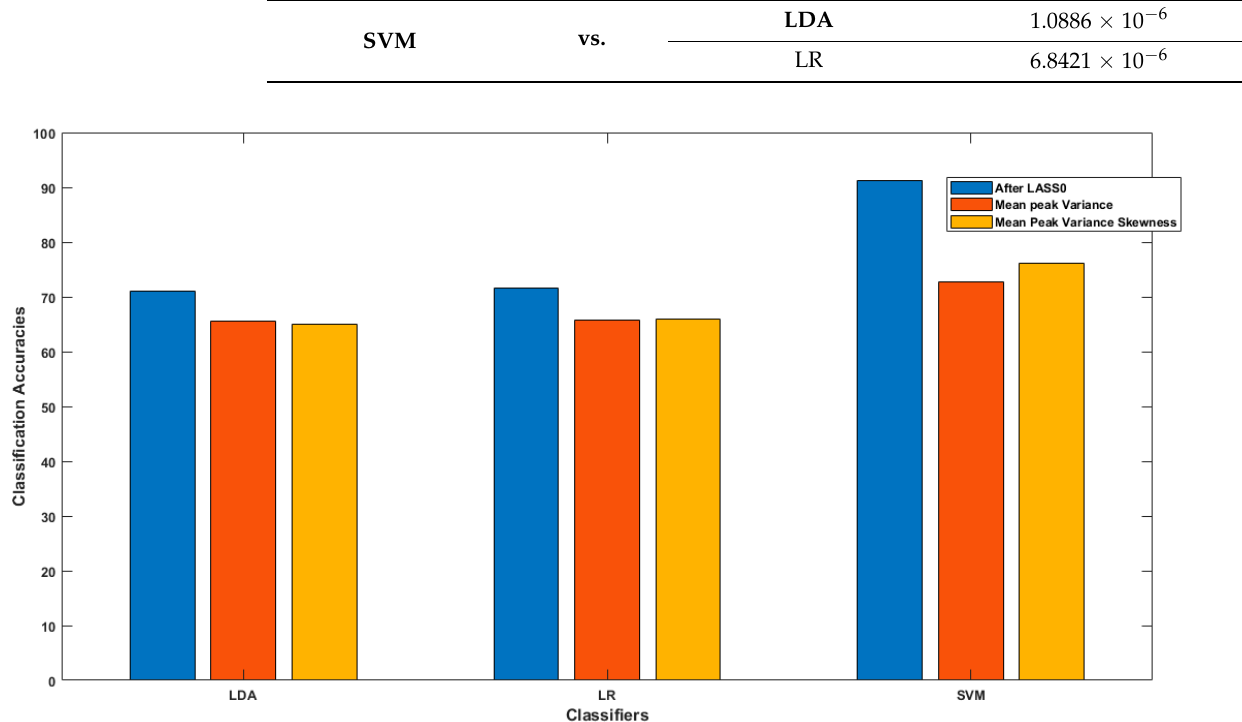
Figure 7. This figure shows a bar chart comparison of average classification accuracies for walking and resting states of all classifiers using both methods